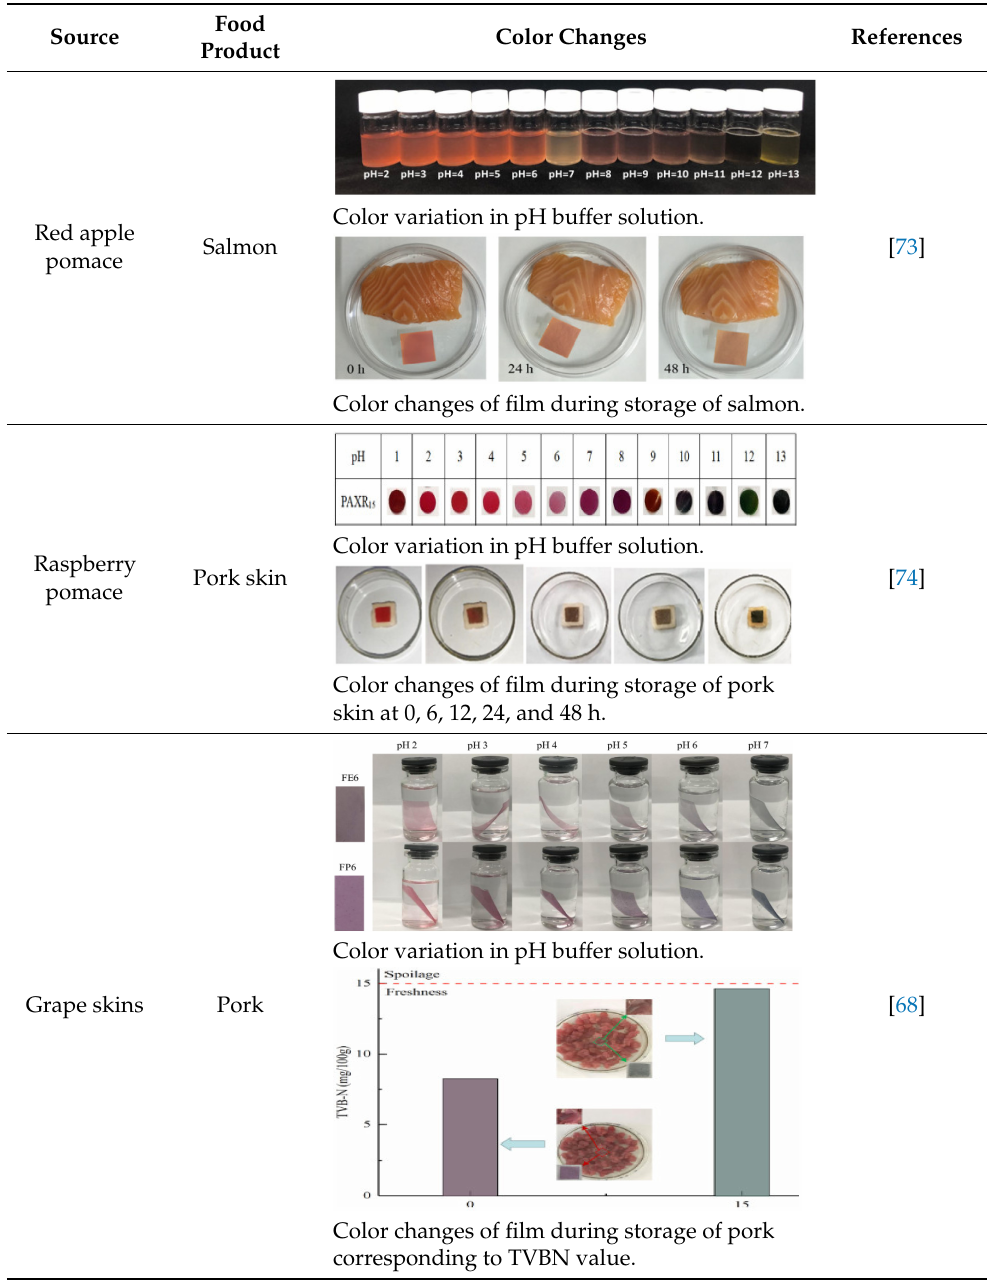
Table 3. Utilization of food waste and by-products as pH-sensitive film.